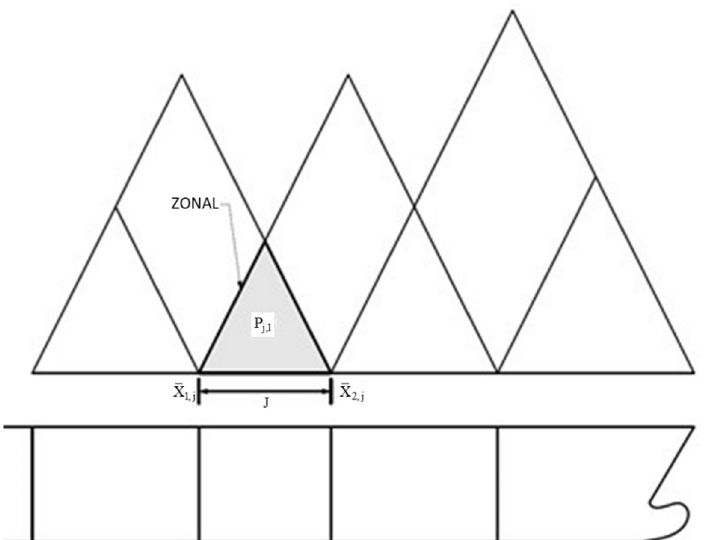
Figure 5. 1-Zone damage example using the zonal method.